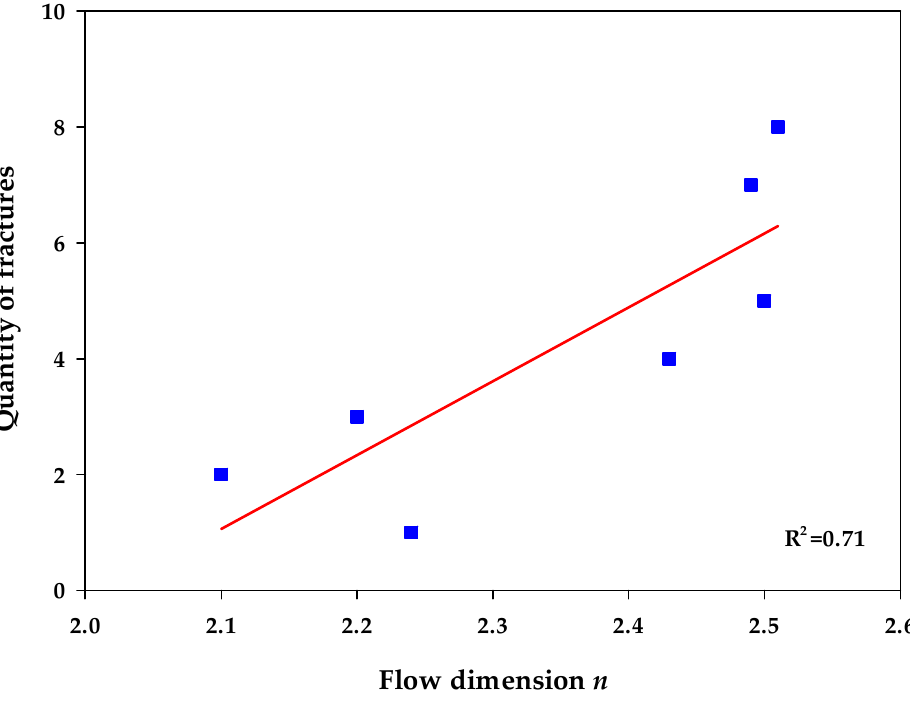
Figure 7. Relationship between n and FD.